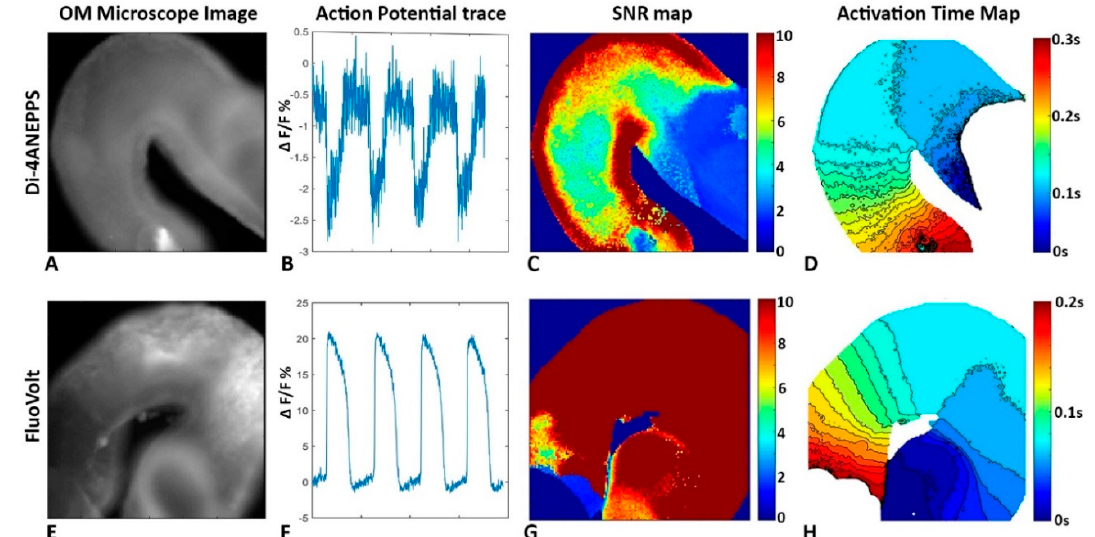
Figure 4. Isochrones calculated from optical mapping (OM) data. HH stage 15 quail embryo hearts were stained with Di-4-ANEPPS or FluoVolt tm and subjected to OM to obtain ( A ) a microscope image, ( B ) AP traces, ( C ) SNR maps, and ( D ) 2-D activation isochrome maps. The use of FluoVolt ( E ) provided a cleaner AP trace ( F ), improved SNR over the heart ( G ), and isochrones maps ( H ).